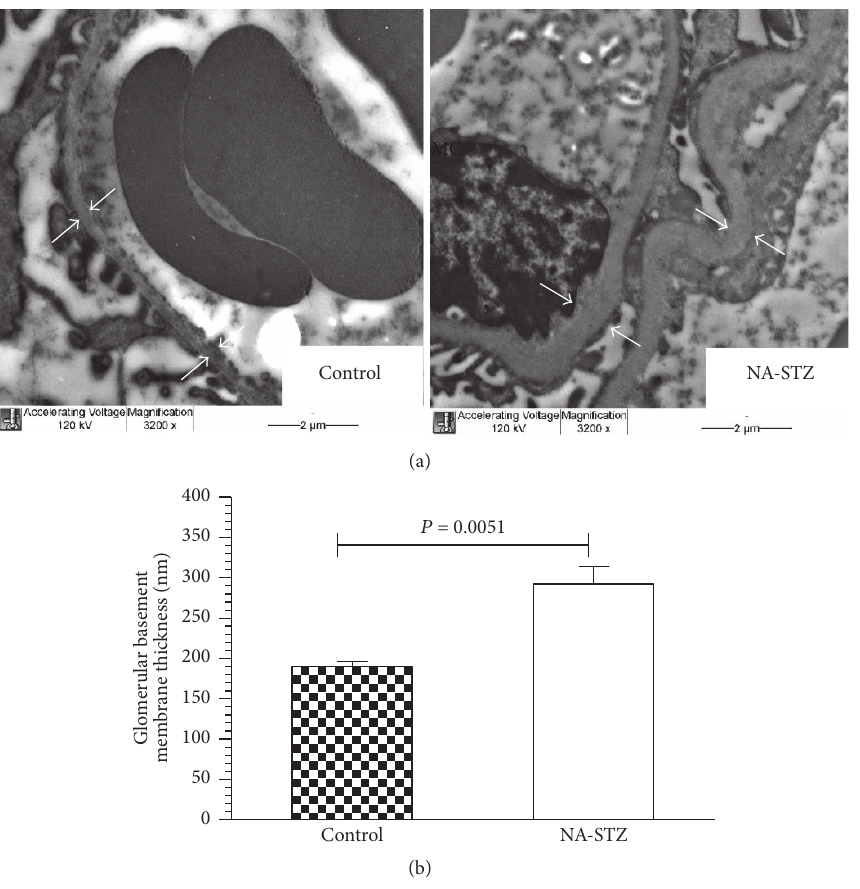
Figure 9: The results of transmission electron microscopic examination in control and NA-STZ-induced diabetic groups at week 30. (a) Representative electron microphotographs (magnification × 3200): white arrows indicate the thickness of the GBM. (b) Quantification of the thickness of the GBM from control nondiabetic and NA-STZ-induced diabetic groups. Mean values and standard deviations are